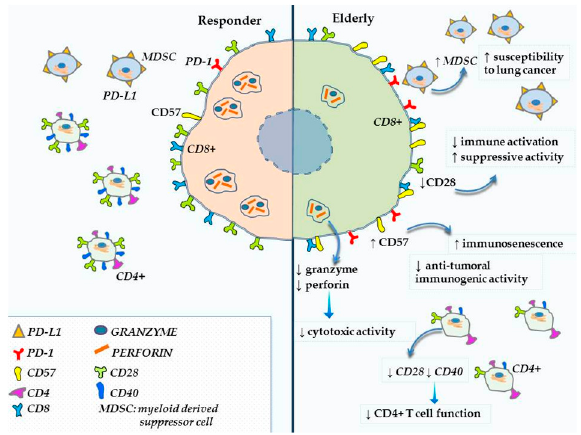
Figure 1. Age dependent dynamic T cell regulation influences immune